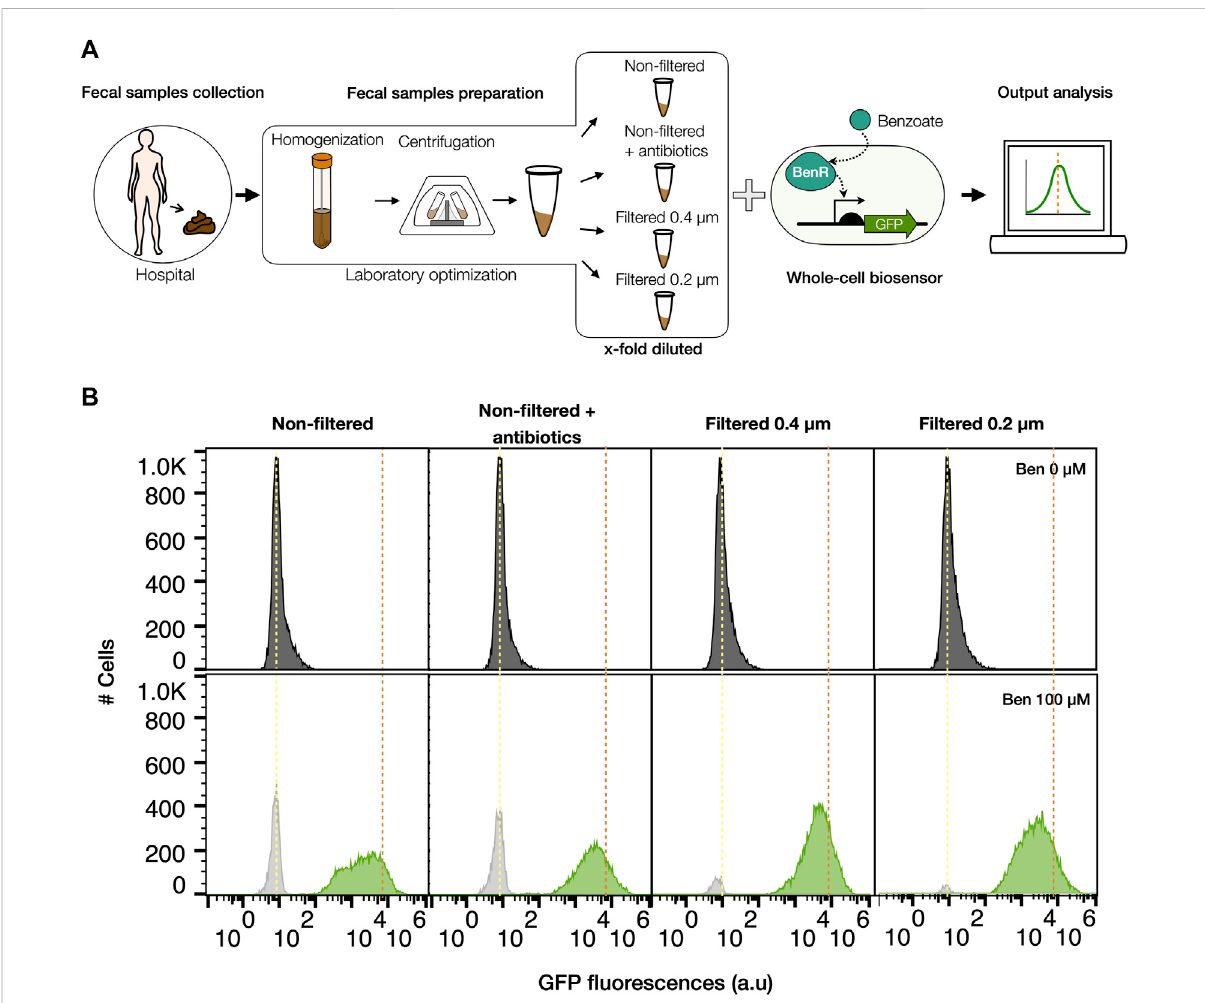
FIGURE 1 Human feces preparation to reduce matrix effects on bacterial biosensorperformance. (A) Schematicwork fl ow ofthe fecal matterpreparation to assessmatrix effect onbenzoate bacterialbiosensor performance.Samples weredefrosted,homogenized, andcentrifuged beforeevaluatingthe pBEN biosensor performance on different fi nal fecal solutions. (B) Matrix effects of different fecal solutions on BenR-pBEN bacterial biosensor. Cells wereinducedwith100 µMbenzoate(bottom)ornon-induced(top)inpresenceofa4-timedilutedfecessampleandincubatedat37 ° Cwithout shakingfor16 h.Darkgrayandgrayhistogramscorrespondtonon- fl uorescentpopulations.GreenhistogramscorrespondtotheGFP- fl uorescence population. Dotted lines represent the mean of the fl uorescence produced by the biosensor growing in LB only, yellow: without benzoate; orange with 100 µM of benzoate. Each histogram is representative of two independent experiments measured by fl ow